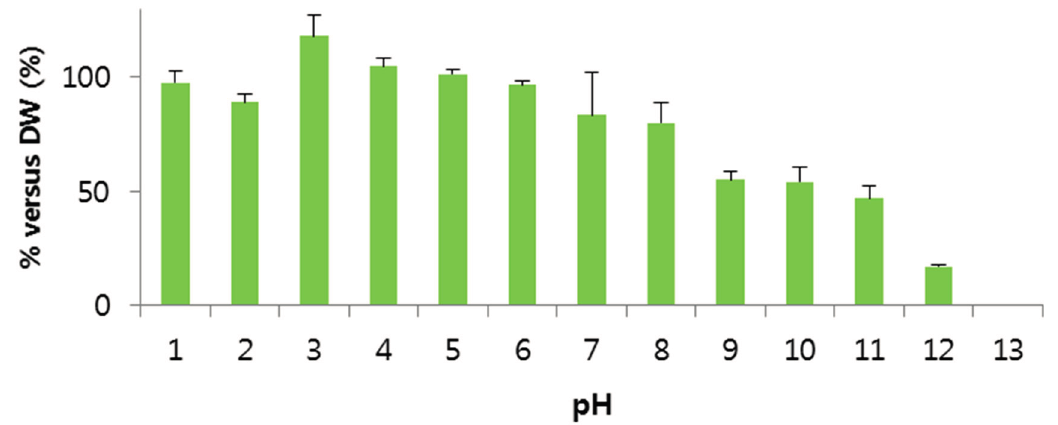
Figure 4. Effect of pH on bee venom. The bee venom was stable in acid condition (pH 1–6). Data are expressed as the mean ± SD ( n =